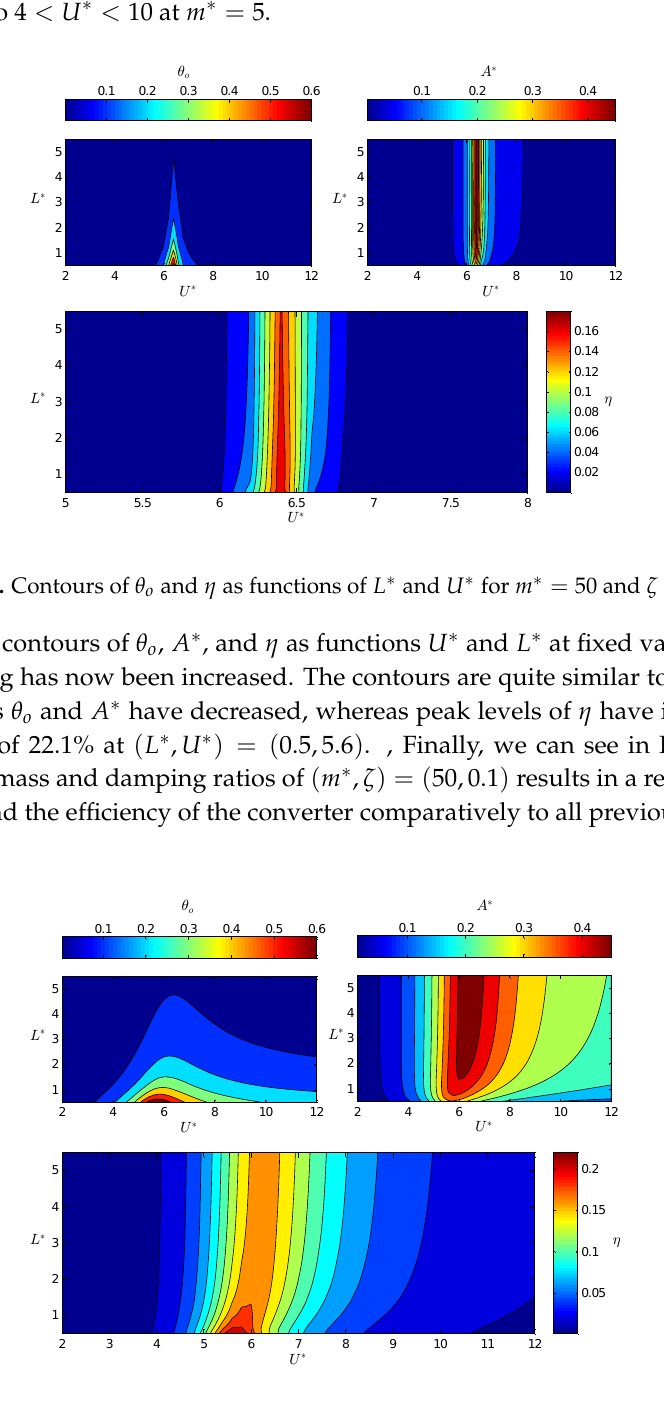
Figure 6. Contours of θ o and η as functions of L ∗ and U ∗ for m ∗ = 5 and ζ =